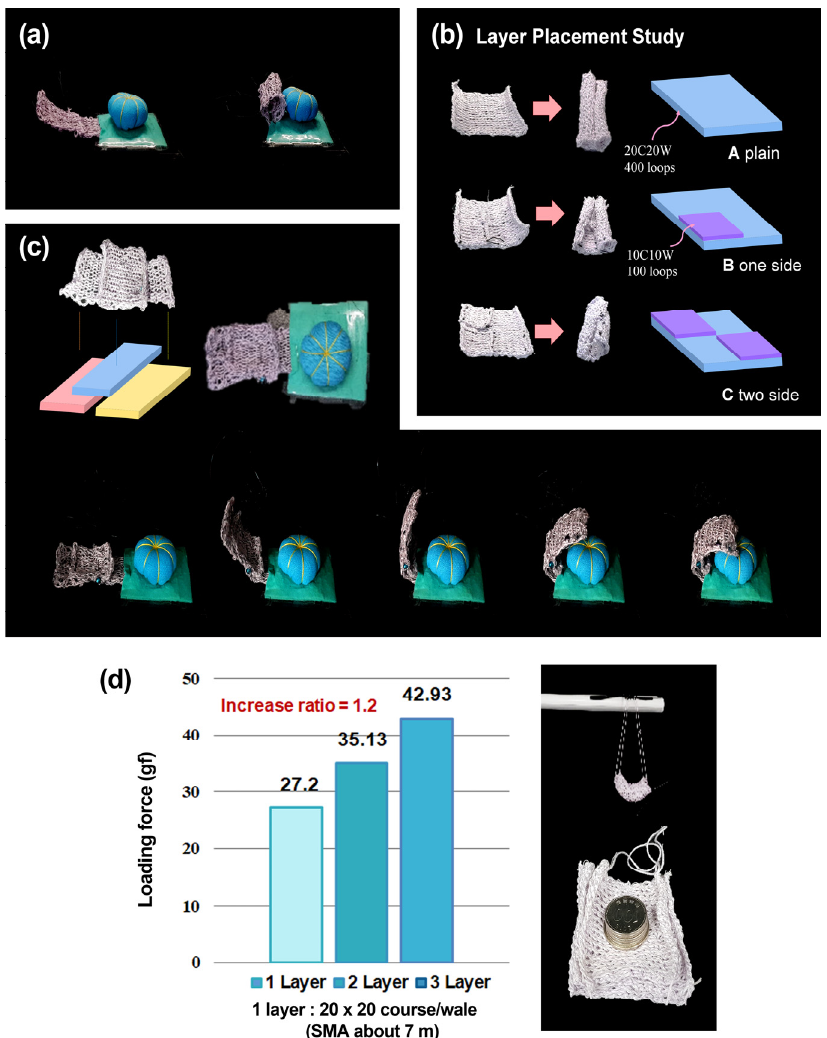
Figure 8. ( a ) The deflection of a single-layered finger; fully curled in. ( b ) The bending behavior when a 10-course and 10-wale actuator was placed on a 20-course and 20-wale actuator. ( c ) A gripper finger with double-layered structure and its verification of the functionality. ( d ) Coin-lifting experiment using several stacked 20-course and 20-wale